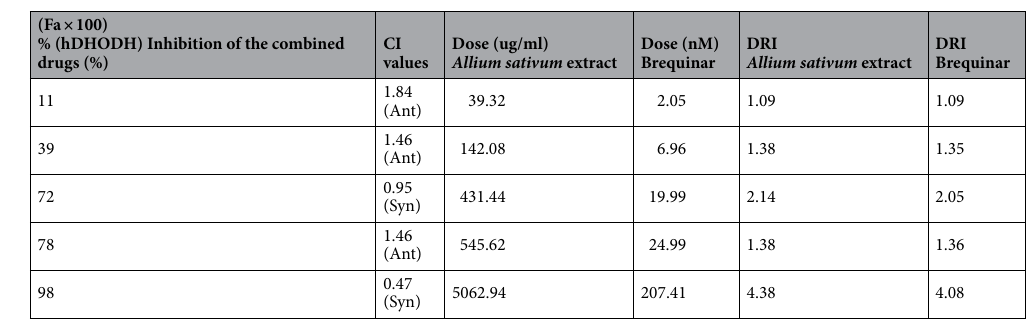
Table 5. Fractional inhibition of hDHODH, combination index values (CI) and DRI values of Allium sativum extract and brequinar in combination at several effect levels. Fa signifies fraction affected. CI < 1, = 1, and > 1 indicate synergism (Syn), additive effect (Add), and antagonism (Ant), respectively. DRI > 1 indicates favourable dose reduction (in fold) for the drug in combination.